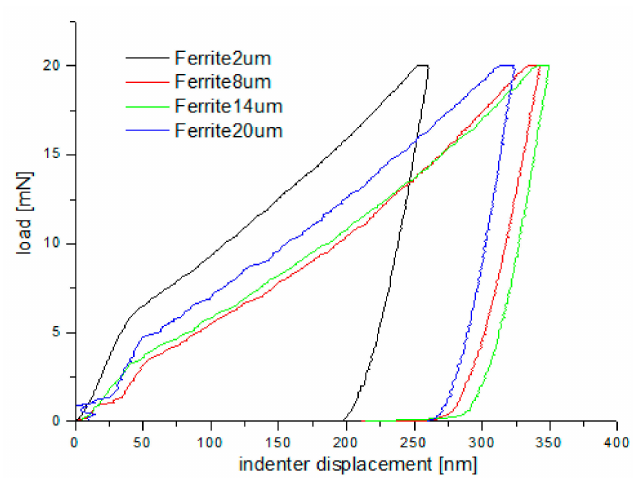
Figure 15. Loading–unloading curves obtained on the cross-section, in the nanoindentation test, for ferrite grains after grinding to di ff erent depths.